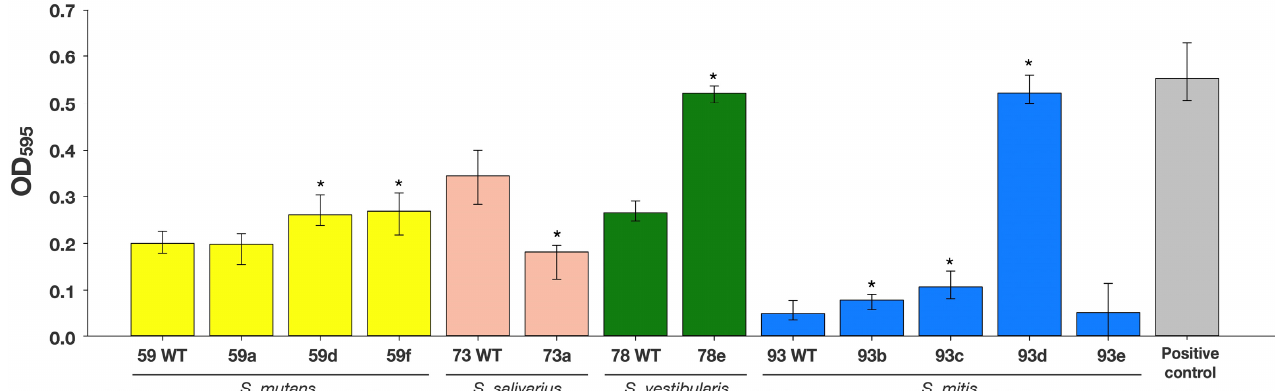
Figure 1. Biofilm formation capacity of P10 replicates showing 8-fold MIC increase toward CHX and corresponding WT strains. Asterisks indicate statistically significant differences from pairwise comparisons between P10 replicates and their respective WT strains. E. faecalis strain T9 was used as positive control for biofilm formation capacity [38].